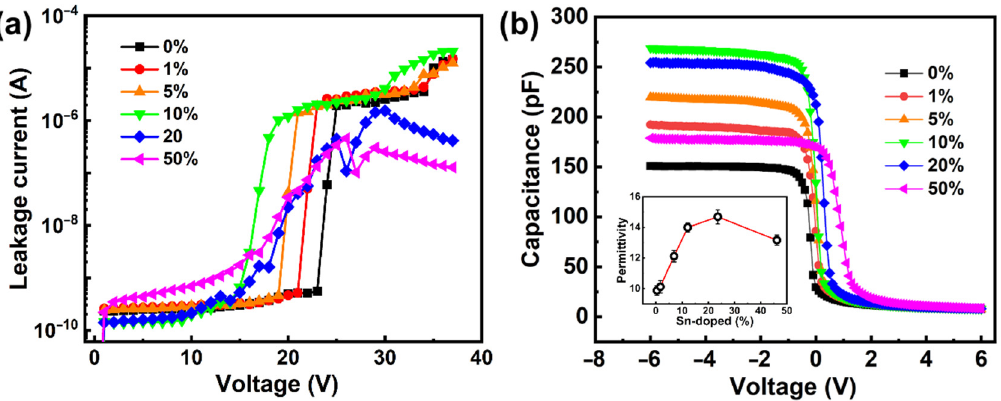
Figure 8. ( a ) I ‐ V curves and ( b ) C ‐ V curves of the Ga 2 O 3 films with different Sn compositions. The inset of Figure 8b displays the variation in the permittivity with the content of Sn.